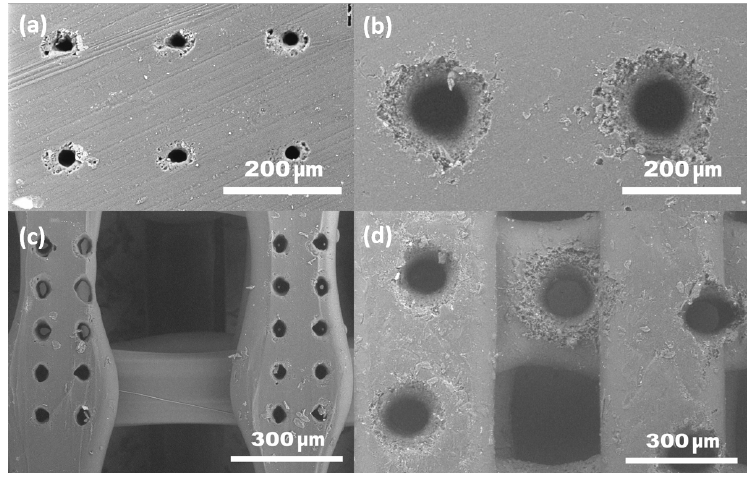
Figure 7. SEM micrographs of microholes drilled in PLA sheet ( left ) and woodpile ( right ): ( a , c ) using sharp focusing; ( b , d ) using